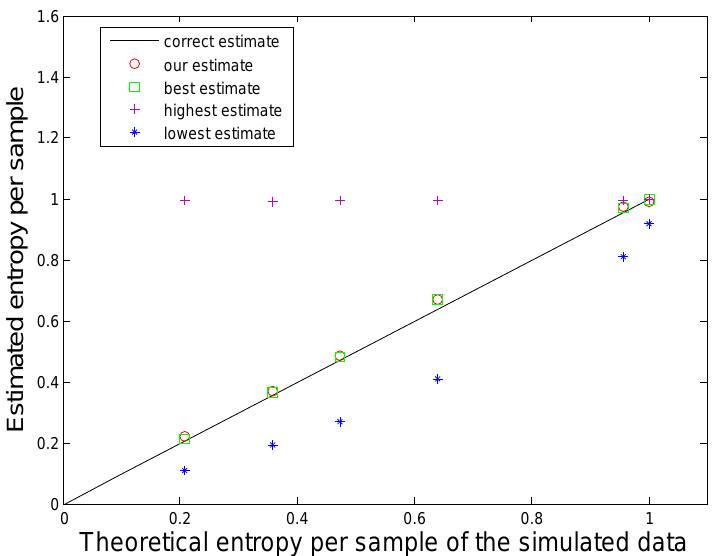
Figure 5: The comparison between our estimator and NIST estimation suite using data from oscillator-based